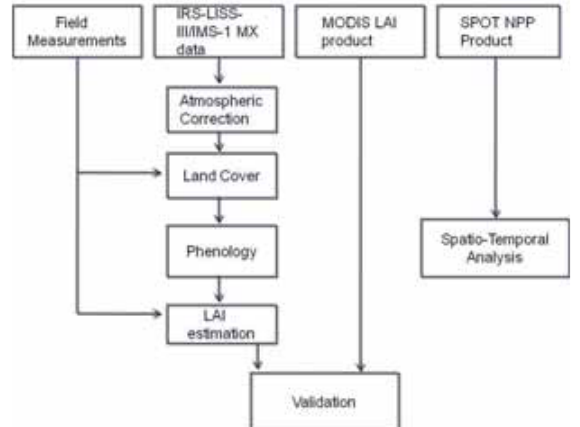
Figure 2. The satellite data and the processing steps used in remote sensing